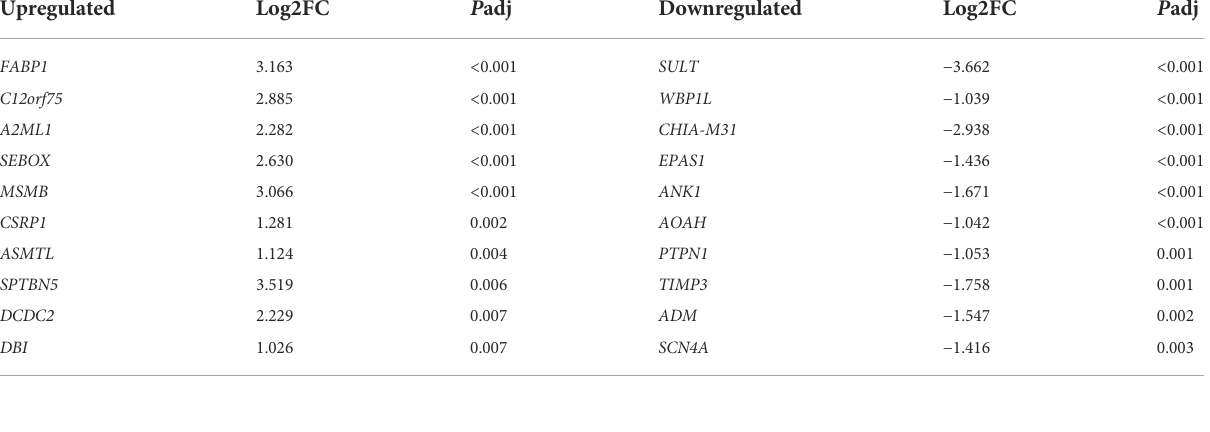
TABLE 2 The top 10 most signi fi cantly up- and down-regulated genes in the liver between the capon and rooster group.